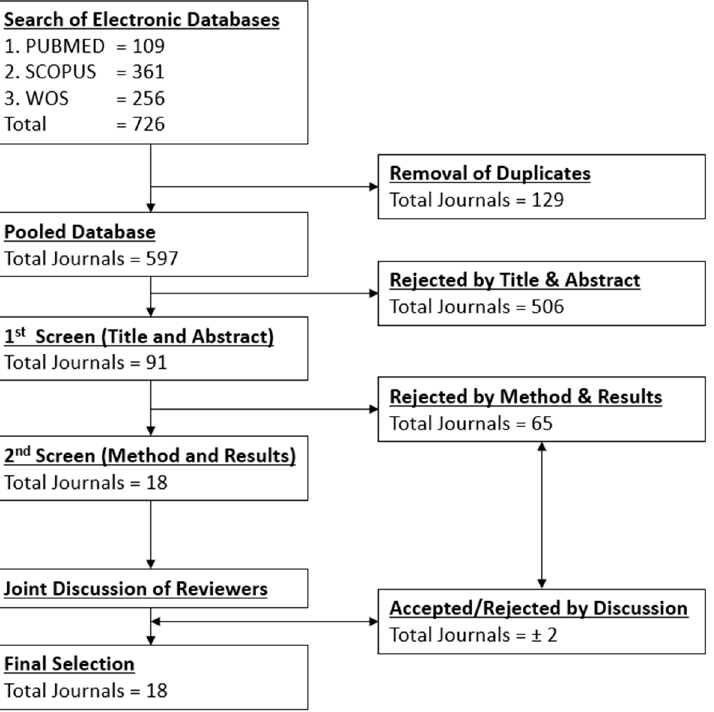
Figure 2. PRISMA flow diagram for process of article selection from pooled database of PUBMED, SCOPUS and WoS.